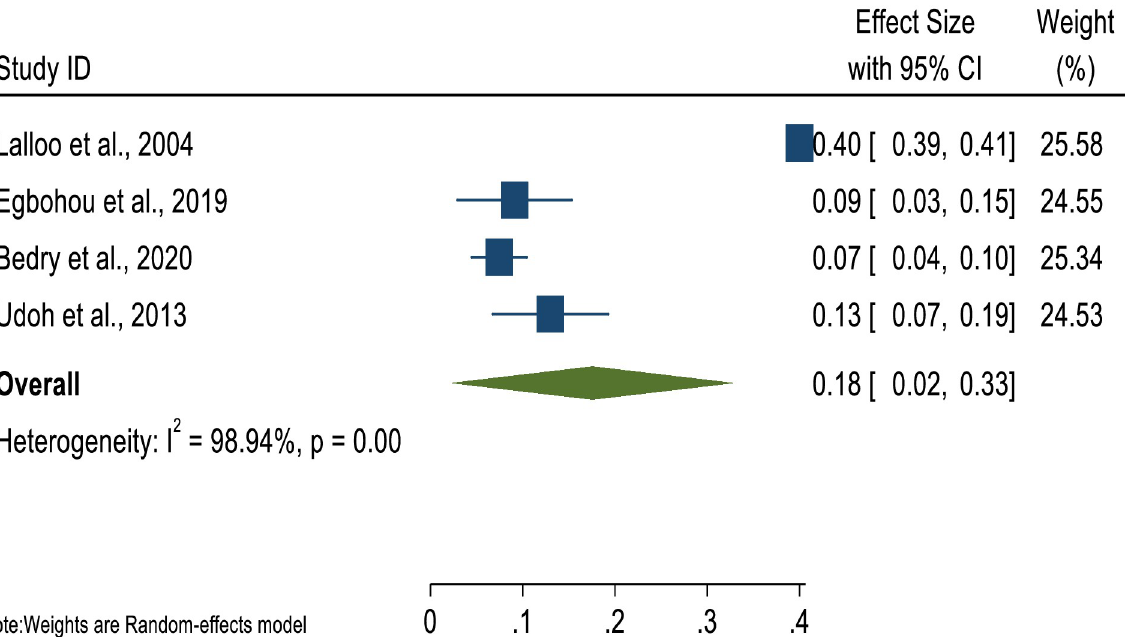
PLOS ONE | https://doi.org/10.1371/journal.pone.0261831 December30,